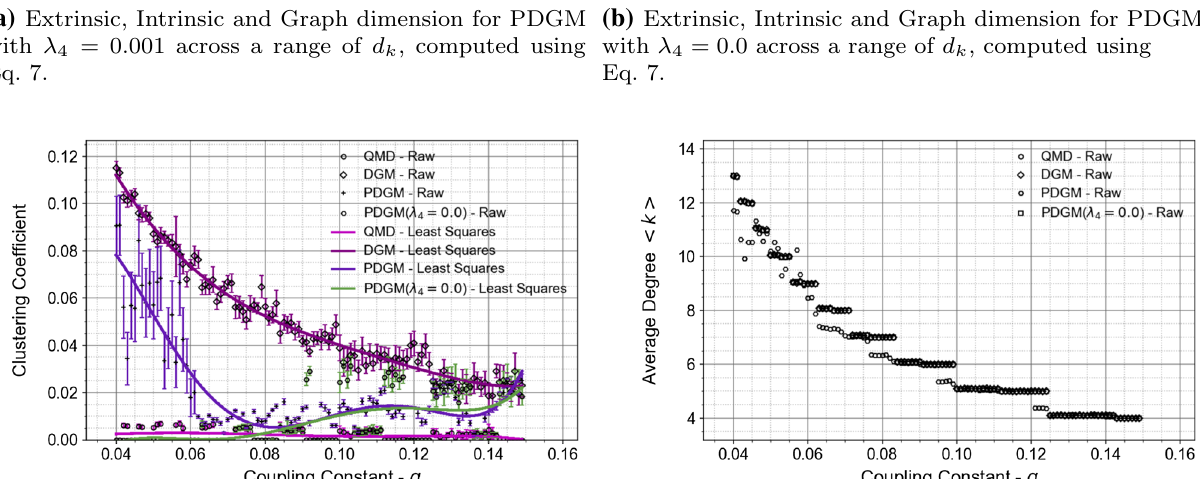
Fig. 6 Comparison of both QMD, DGM and PDGM clustering coeffi- cients and average degree across a range of graph sizes. Each datapoint represents the average value across 10 graph samples. Against each of the data points the error bars represent the 1st standard deviation